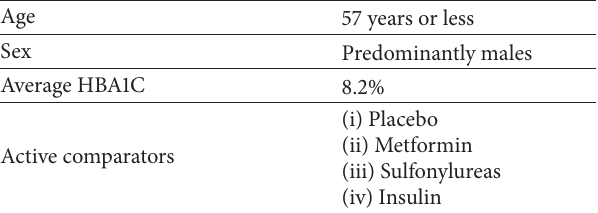
Table 3: Baseline characteristics [6].